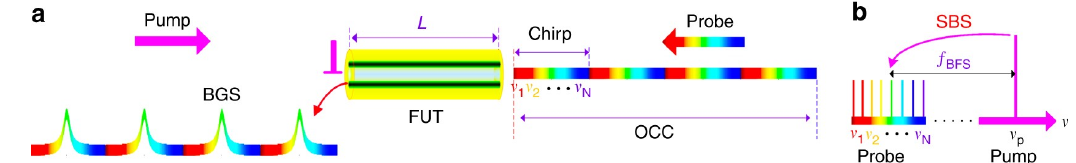
Figure 23. Principle of operation of the single-shot BOTDA based on the use of an OCC probe wave. ( a ) OCC probe wave is composed by several short optical chirp segments ( b ) Frequency relation between the pump pulse and the probe beam [70].